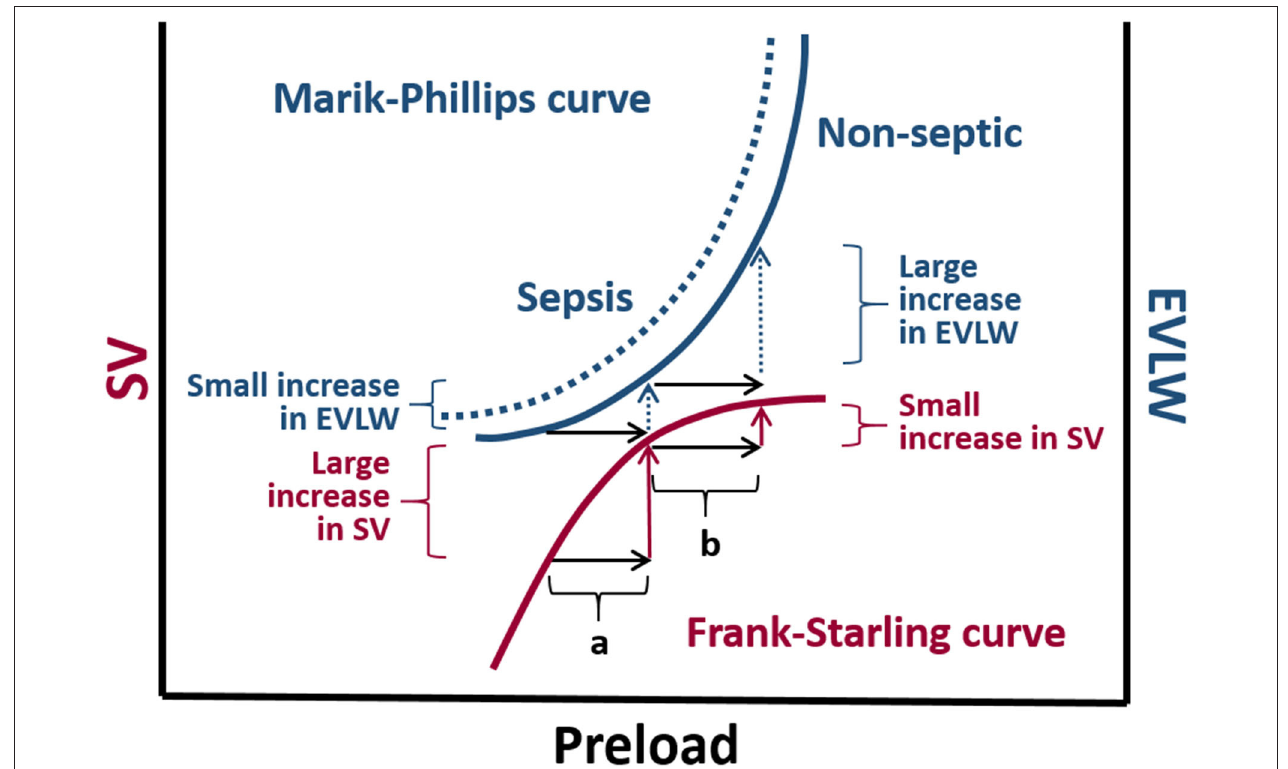
FIGURE 6 | The Marik-Phillips curve and the Frank-Starling curve correlating changes in extra vascular lung water (EVLW) and stroke volume (SV) with preload, respectively. For individuals whose heart is operating on the ascending limb of the Frank-Starling curve, an increase in preload induced by a fluid challenge (a) does not substantially increase EVLW. If a fluid challenge is administered to individuals whose heart is operating on the flat portion of the Frank-Starling curve, the increase in preload (b) may result in a large increase in EVLW. Due to endothelial glycocalyx damage associated with sepsis, larger increases in EVLW can be expected in septic individuals (dashed